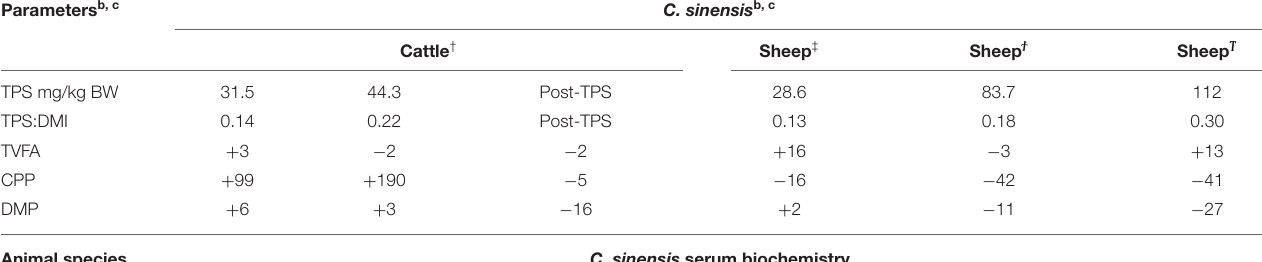
TABLE 2 | The effects of supplementing triterpenoid saponin (TPS) from Camellia sinensis L. or Medicago sativa L. on digestive and blood profiles of † Belmont Red Composite [Africander (African Sanga) × Brahman ( Bos indicus ) × Hereford-Shorthorn (3/4 B. taurus )] and Brahman steers, and ‡ Dorper crossbred × thin-tailed Han ewes, Hu rams, Huzhou lambs and * Hu male-lambs a . Parameters